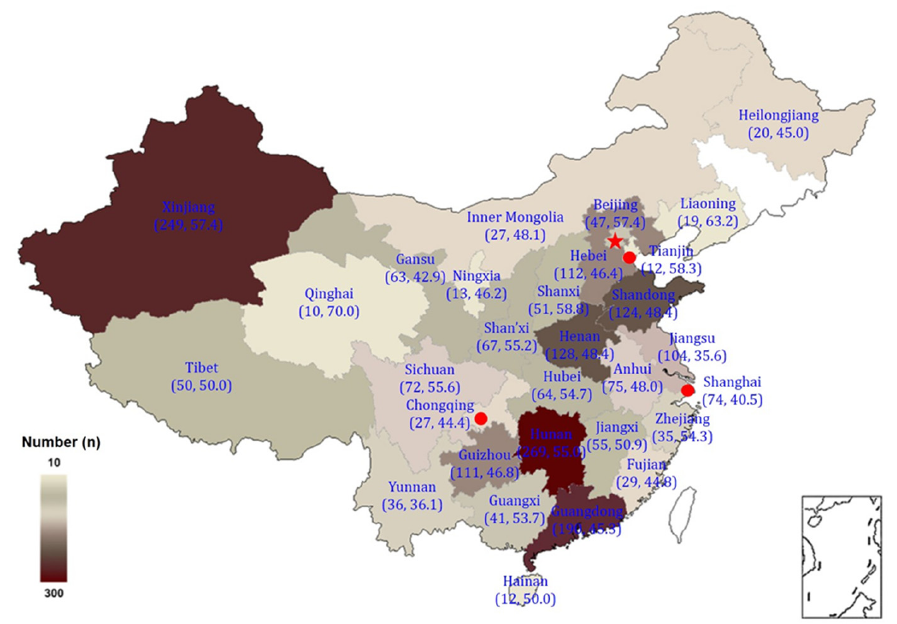
Figure 1. Distribution of the surveyed number , and happiness rate ( n , %) among students from universities across China ( n = 2186).